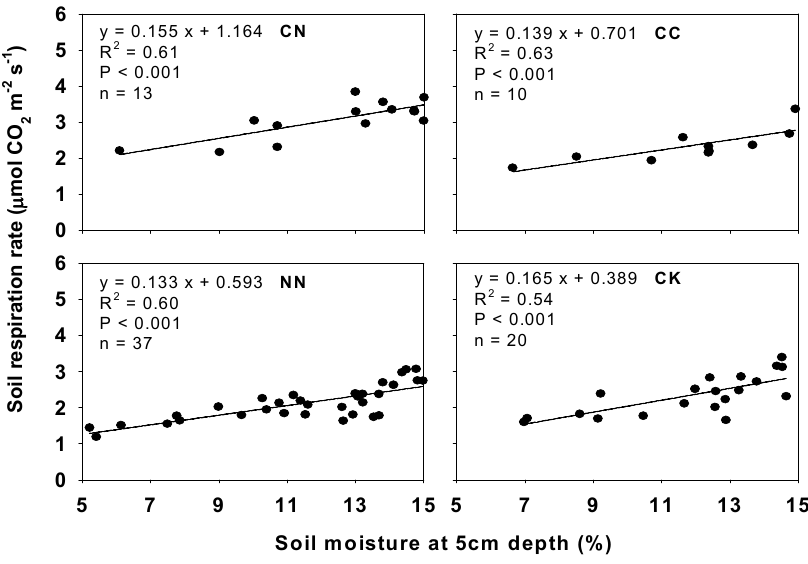
Fig. 3. Relationships between soil respiration rate and soil moisture of the top 5cm soil layer (below 15%) under different CO 2 and N treatments. Each datum in panels CN and CC is the mean of three replications. Each datum in panels NN and CK is the mean of two replications. The treatments are: CK = control, NN = high N, CC = elevated CO 2 , CN = elevated CO 2 + high